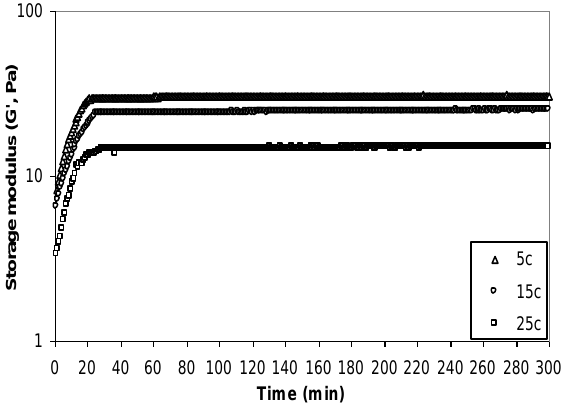
Figure 9. Evolution of storage modulus (G ′) with time of Yanang gum 2% ( w / v ) .